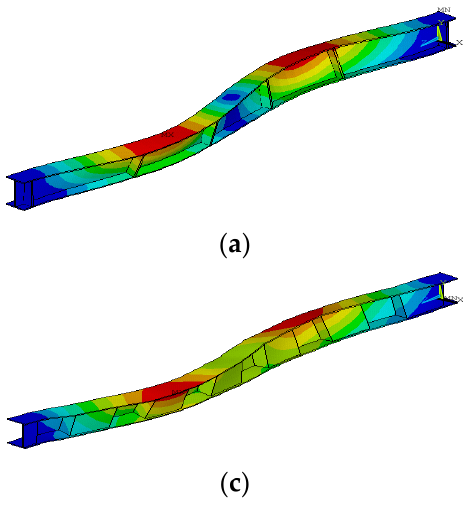
Figure 7. Pattern of 2nd flexure displacement mode shapes: ( a ) flat web with stiffener, ( b ) trapezoidal web, ( c ) rectangular web, and ( d ) triangular web.